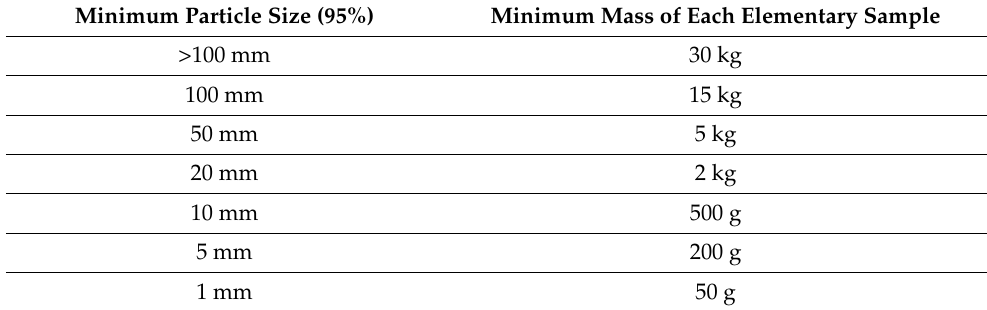
Table 2. Representative Sampling of